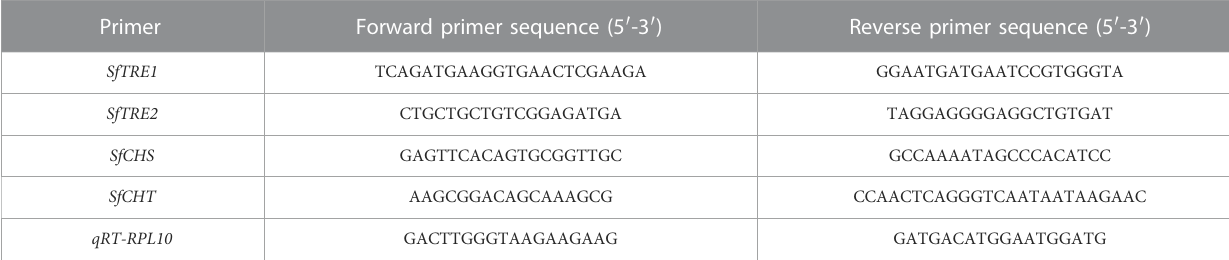
TABLE 2 Primer sequences of S. frugiperda . Primer Forward primer sequence (5 ′ -3 ′